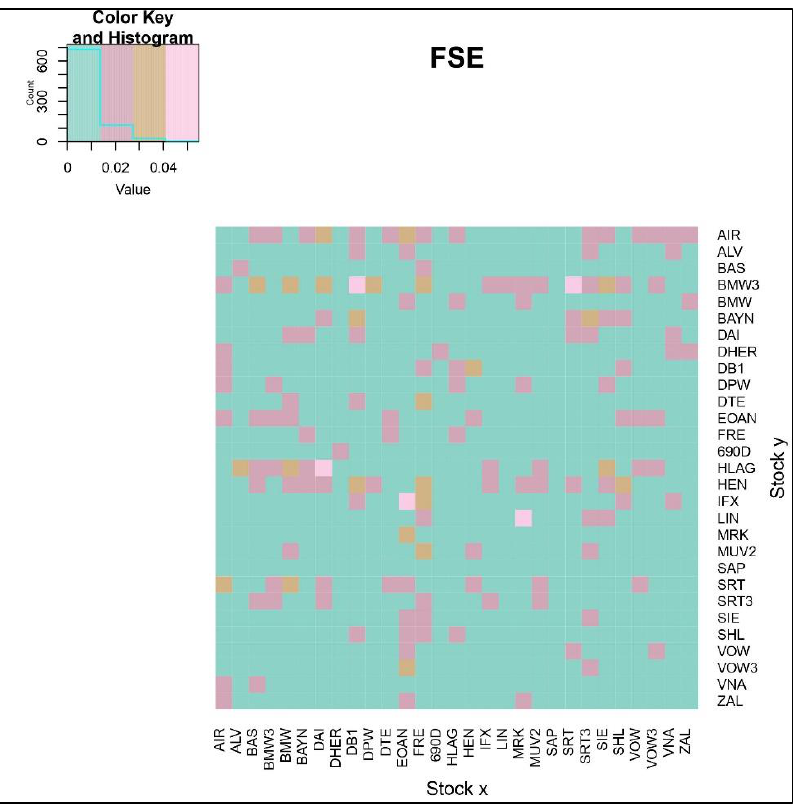
Figure 6. The information flow (effective transfer entropy) from stock y to stock x, for the top companies (by market capitalization) in the FSE market, after the COVID-19